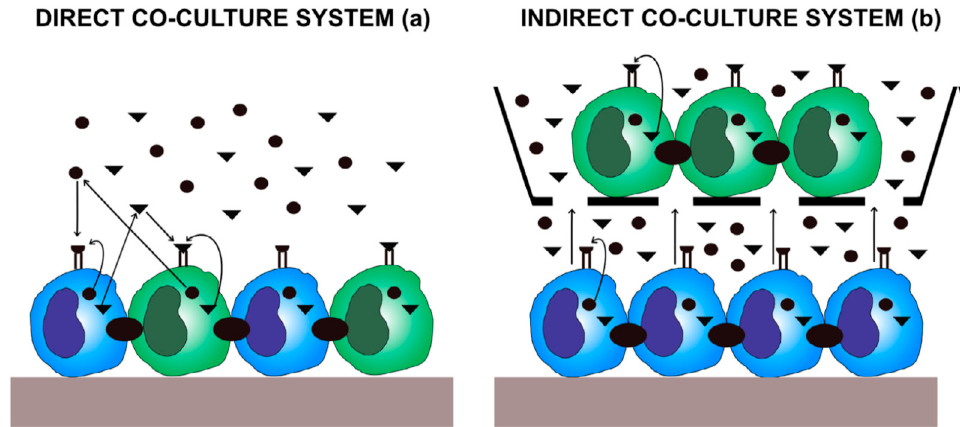
Figure 2. Diagrammatic representation of the cell interactions in the co-culture systems. In the direct co-culture model ( a ) cell–cell communication occurs through direct cell contact, while ( b ) indirect cell con- tact is communicated by autocrine and paracrine approaches (adapted from Borciani et al. (2020)